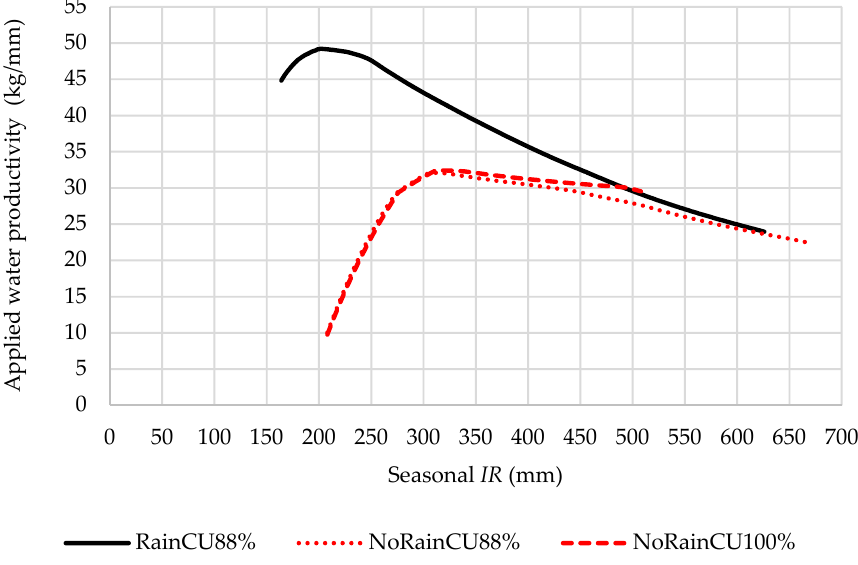
Figure 8. Applied irrigation water ( IR ) productivity for a uniform (CU100%) and a non-uniform (CU88%) application in the presence of rainfall (Rain) and no rainfall (NoRain).